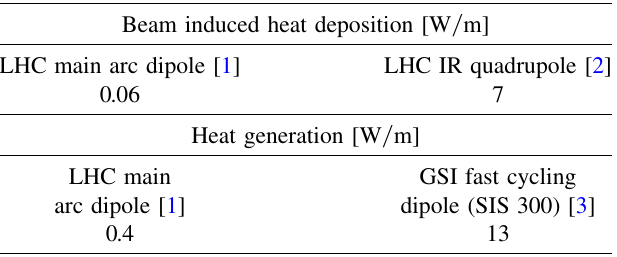
TABLE I. Heat loads on different types of SC